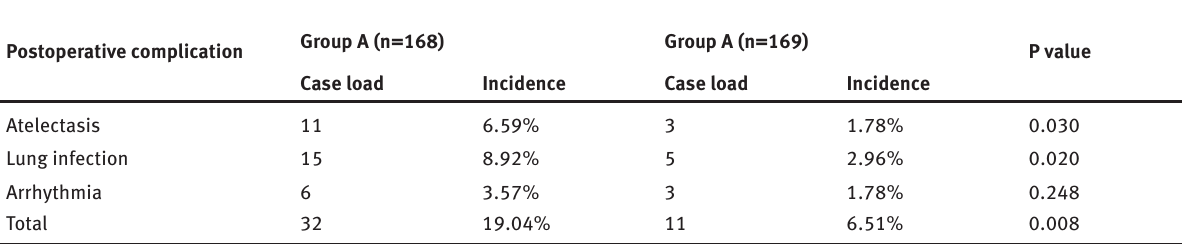
Table 4: Comparison of incidence of postoperative complications between the two groups of patients